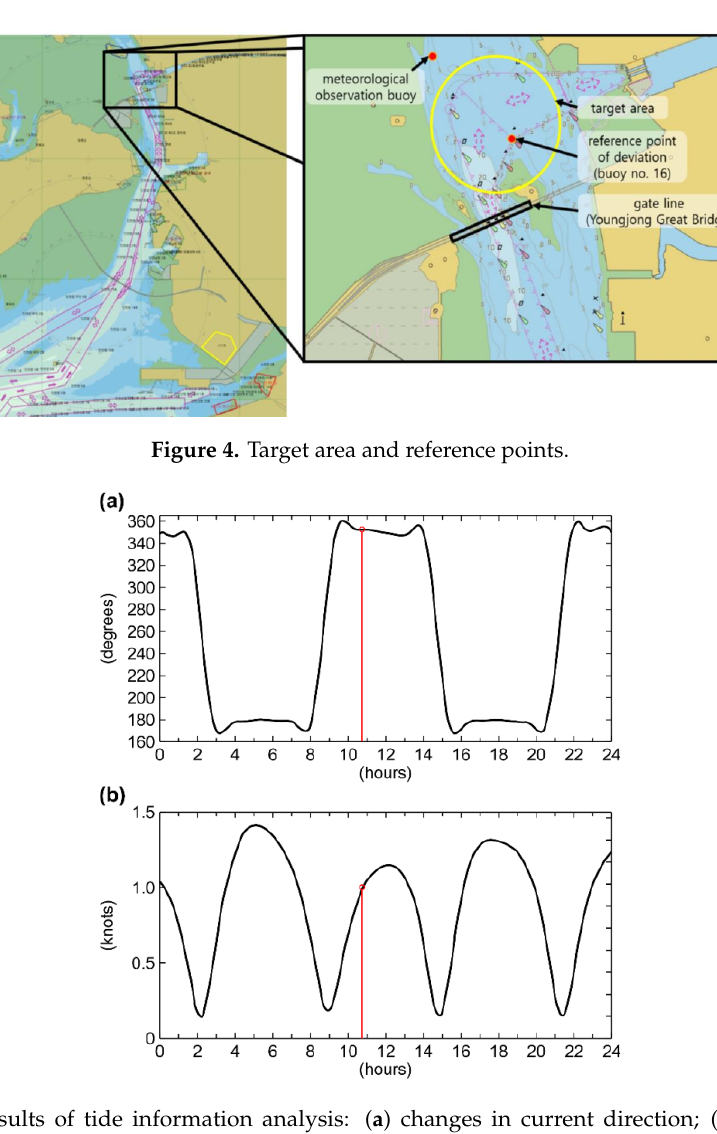
Figure 5. Results of tide information analysis: ( a ) changes in current direction; ( b ) changes in current